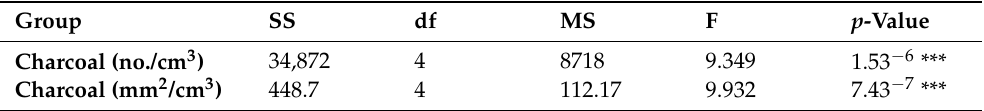
Table 5. Summary of average values of M1 and M2 treatment groups in the upper core (S1) and lower core (S2). Minimum, maximum, and range of CI and charcoal influx area (mm 2 /cm 3 ) and count (No./cm 3 ) across sections S1 and S2 are displayed.